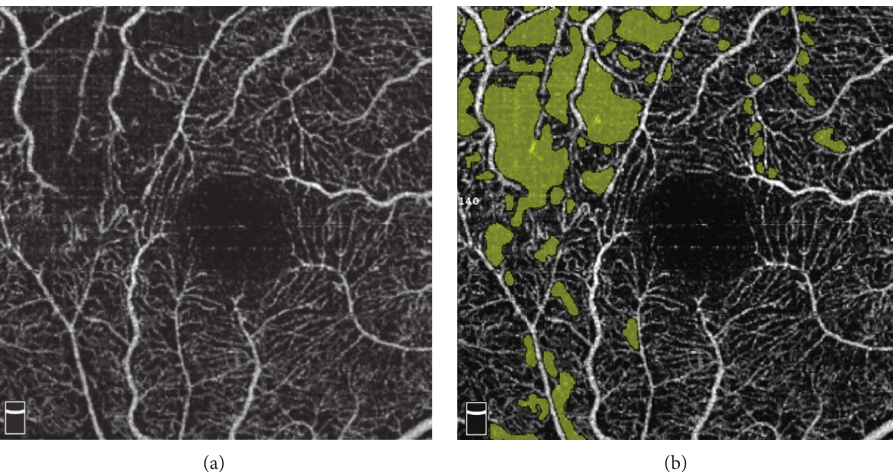
Figure 2: OCTA image of a right BRVO eye. (a) The original OCTA image of the superficial layer. (b) The yellow mask showed the NFA.